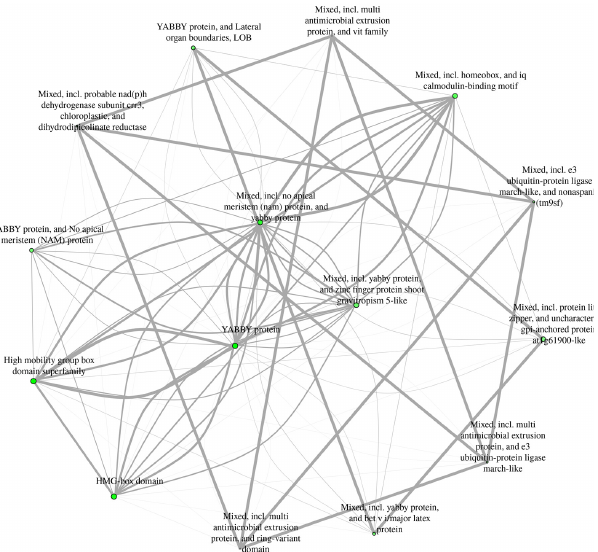
Figure 6. Static network enrichment graph, showing the network of StYAB gene functions. The darker nodes are more the significantly enriched gene sets. The bigger nodes represent the larger gene sets. The thicker edges represent more overlapped genes.